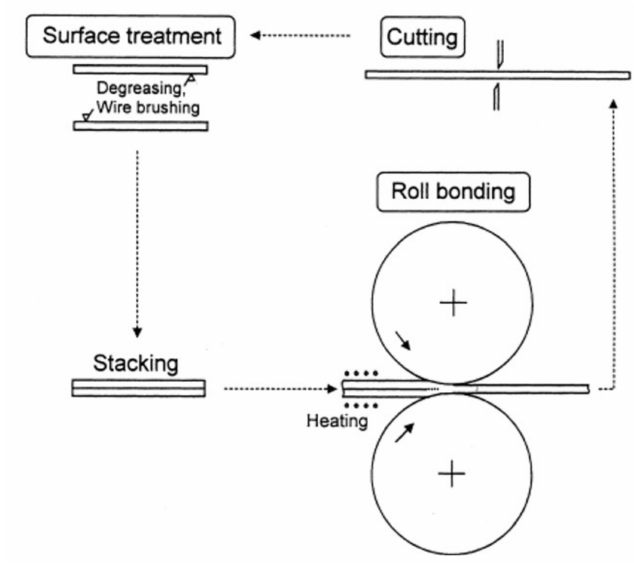
Figure 4. Schematic of accumulative roll-bonding (ARB) process [25]. (© 1999, Elsevier. Used with